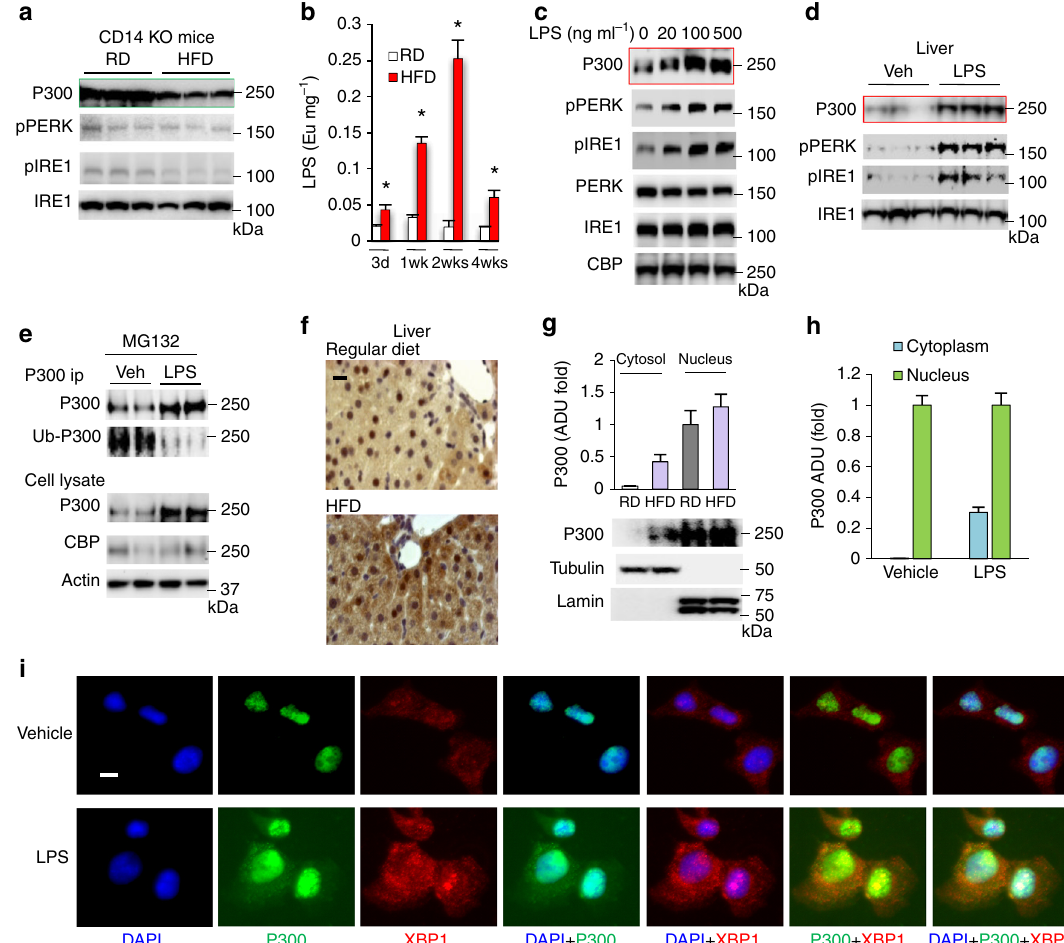
Fig. 2 Elevation of hepatic LPS levels by HFD feeding leads to P300 induction. a CD14 knockout mice were fed on a regular chow diet or an HFD for 2 weeks. b LPS levels in the liver of mice fed an HFD for up to 4 weeks ( n = 4). Each bar represents the mean ± s.e.m. *, P < 0.05, Student ’ s t -test. c Hepa1- 6 cells were treated with indicated amount of LPS for 24 h. d LPS (0.5 μ g per g of body weight per day) was administrated to C57BL/6 mice through intraperitoneal injection for 2 weeks. e Hepa1-6 cells were treated with vehicle or LPS (500 ng ml − 1 ) for 24 h, followed by the treatment with (20 µ M) MG132 for 4 h. Cell lysates were incubated with antibody against P300 (16 h, 4 °C). f C57BL/6 mice were fed on an HFD for 2 weeks, frozen liver tissues were sectioned and immunostained with P300 antibody. Scale bar, 20 µ m. g Cytoplasmic and nuclear extracts were prepared from the liver of mice fed a regular diet or HFD for 2 weeks ( n = 3). h Densitometric analysis of P300 in the cytoplasm and nucleus in hepatocytes treated with LPS as in Fig. 2i ( n = 8). i Forty-eight hours after the treatment with LPS (50 ng ml − 1 ), Hepa1-6 cells were subjected to immuno fl uorescence staining. Scale bar, 10 µ m. a , d